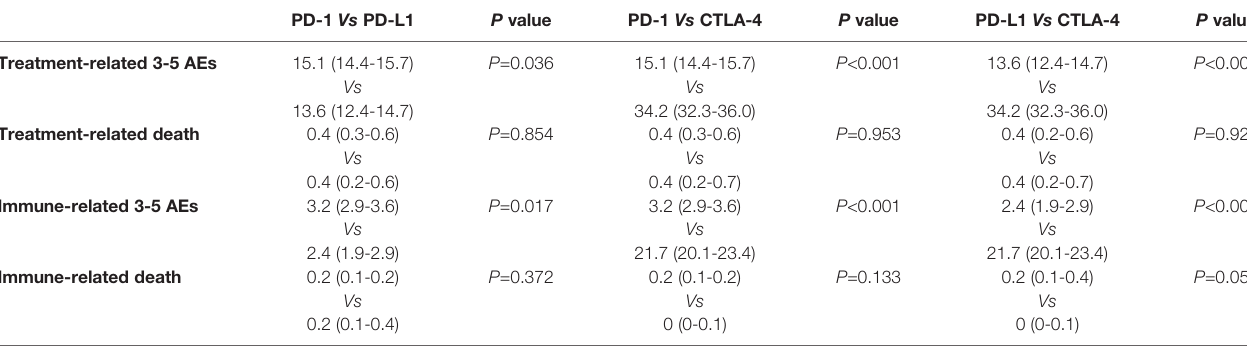
TABLE 4 | Comparison of grade ≥ 3 trAEs and irAEs from 3 ICIs.